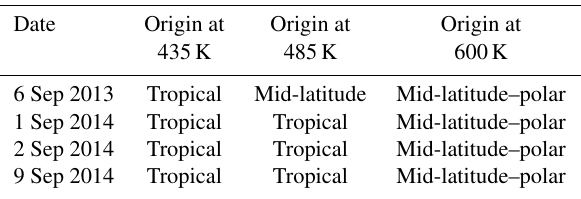
Table 5. Origin of ozone-poor air at isentropic levels for low-ozone events in September.